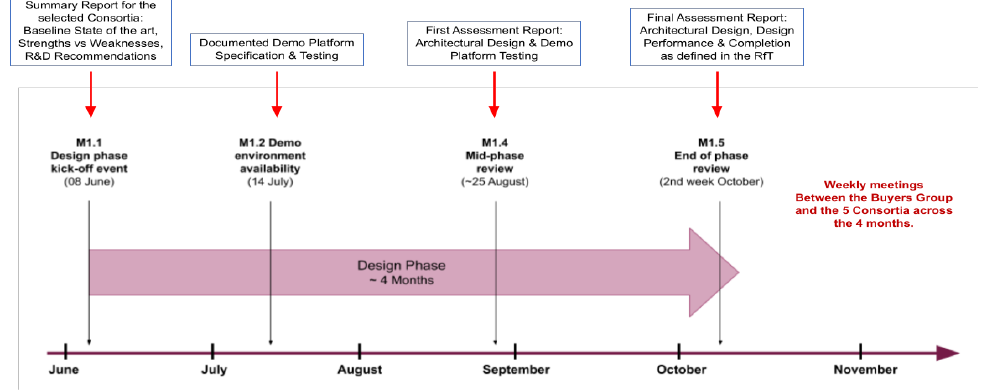
Fig. 4. Design Phase timeline and R&D monitoring checkpoints.